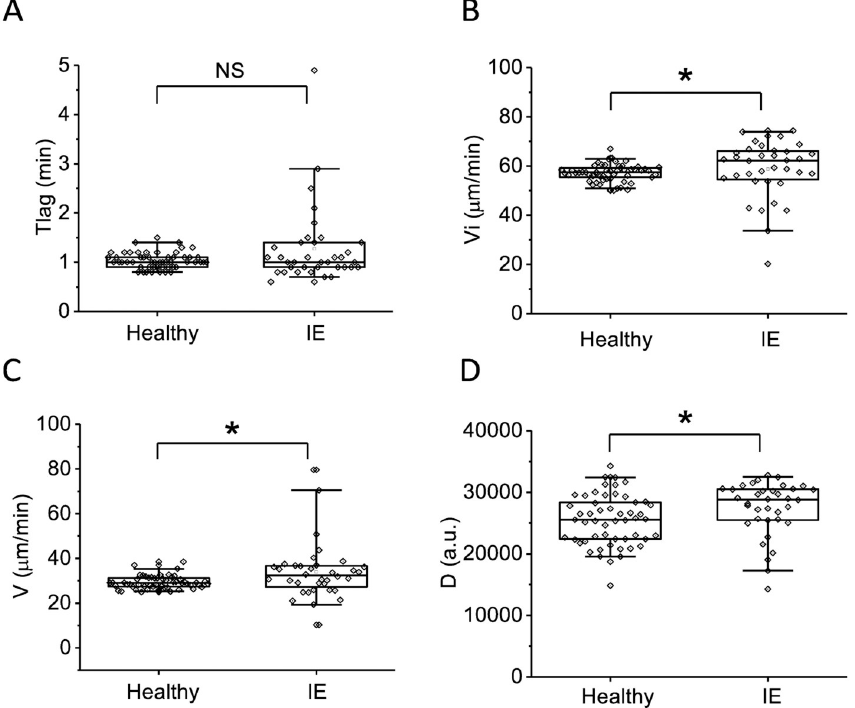
Fig 4. Parameters of the thrombodynamics in IE patients and healthy volunteers at admission. A—Tlag (min), B— Vi ( μ m/min), C—V ( μ m/min), D—D (a.u.). The box plots indicate the following parameters: the mean value (the dot inside the box), the median (the horizontal line inside the box), the 25 th and 75 th percentiles (the bottom and top of the box, respectively) and 5 th and 95 th percentiles (the ends of the whiskers). Groups were compared according to Mann- Whitney test; � p < 0.05, �� p < 0.01, ��� p < 0.001, NS—not